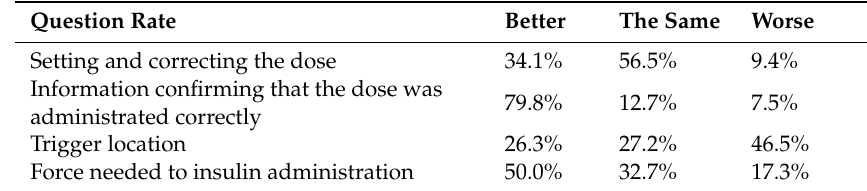
Table 3. Questionnaire surveyed at telephone contact comparing the GensuPen to the a previously used pen ( n = 258).